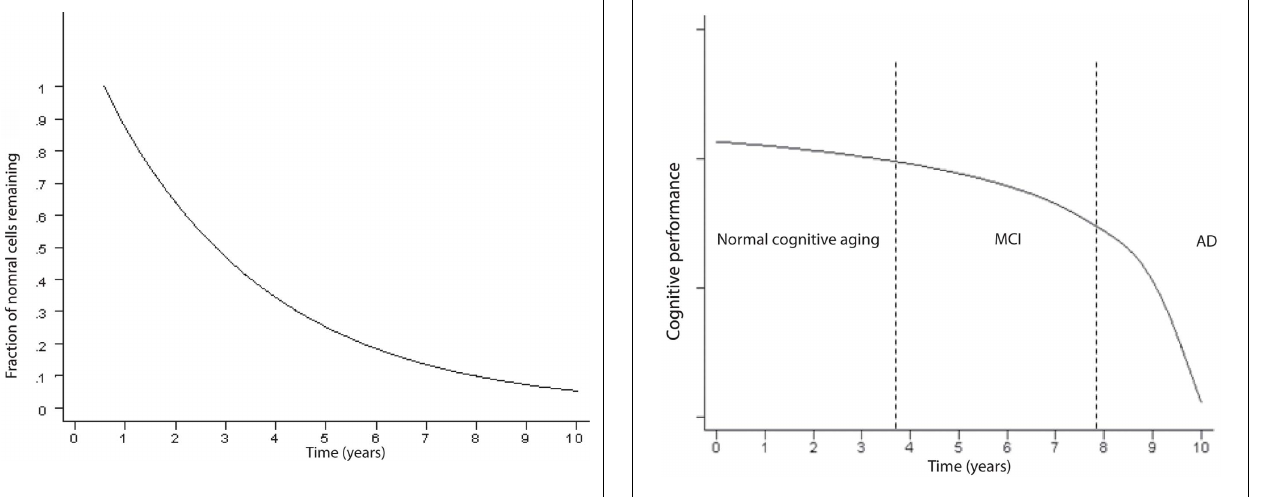
FIGURE 4 |Time course of the impairment continuum of cognition (adapted; Small et al.,